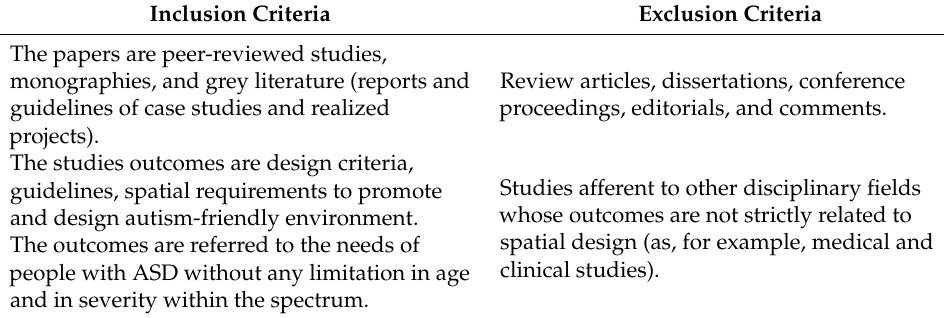
Table 2. Eligibility criteria. Inclusion